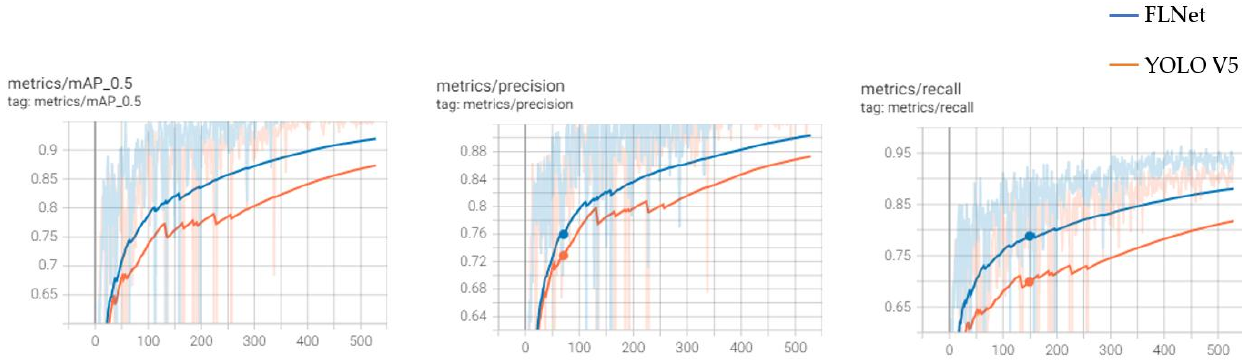
Figure 13. Performance of the two detection algorithms in the training process.